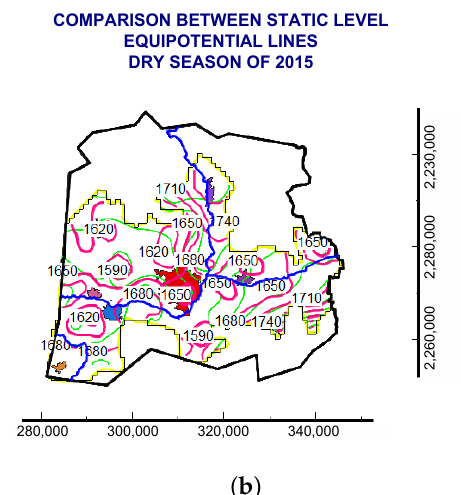
Figura 2.7: Comparaci´on entre las l´ıneas equipotenciales de los niveles piezom´etricos calculados por el modelo (Color Rosa) y los medidos en campo (Color Verde) de la temporada de Secas. Figure 10. Dry season. ( a ) Hydraulic head in steady state, where the highest head is represented by red and the lowest head by dark blue. ( b ) Comparison between the equipotential lines of the Temporada de Lluvias piezometric levels calculated by the model (pink color) and those measured in the field (green color).